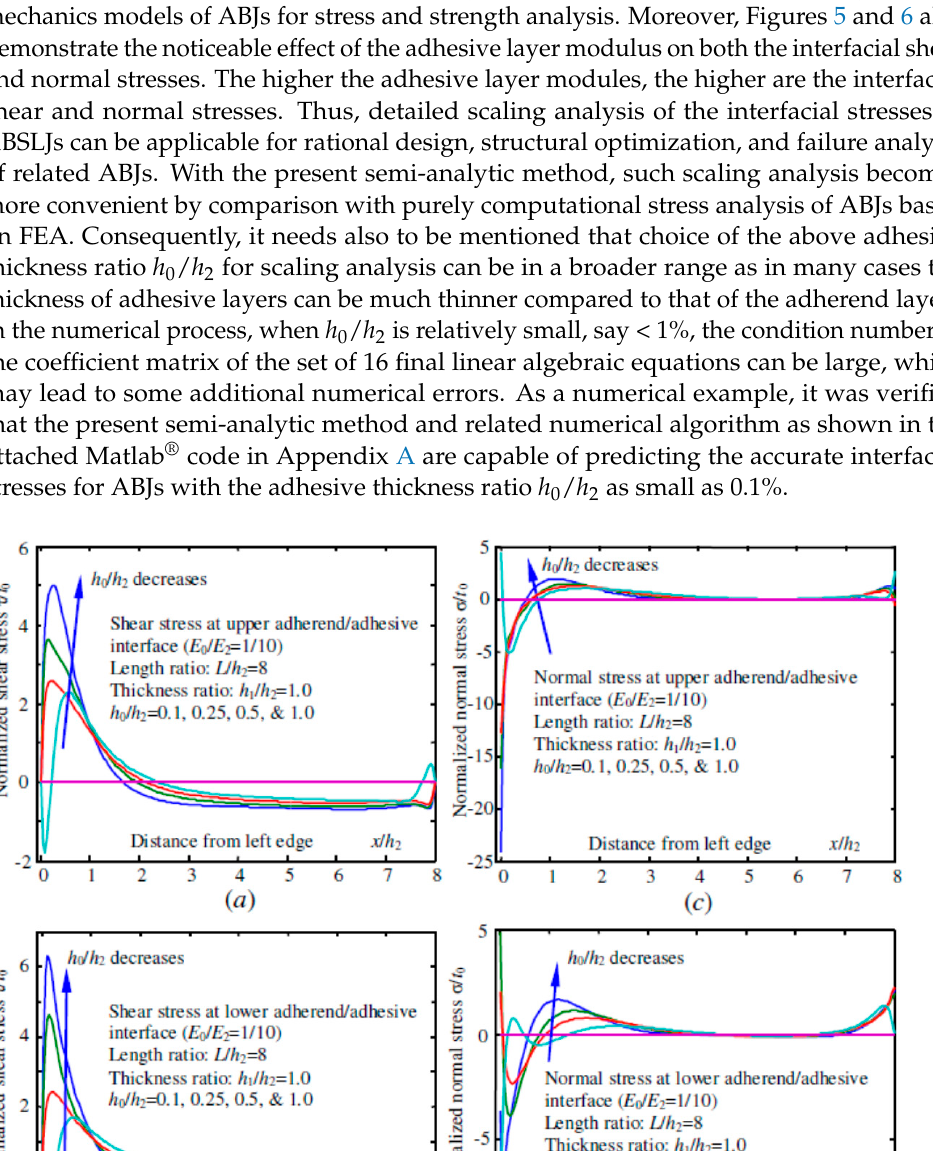
Figure 6. Comparison of the interfacial shear and normal stresses at the upper and lower ad- herend/adhesive interfaces subjected to a shear force ( E 0 / E 2 = 1/5, h 1 / h 2 = 1.0, and h 0 / h 2 = 0.1, 0.25, 0.5,